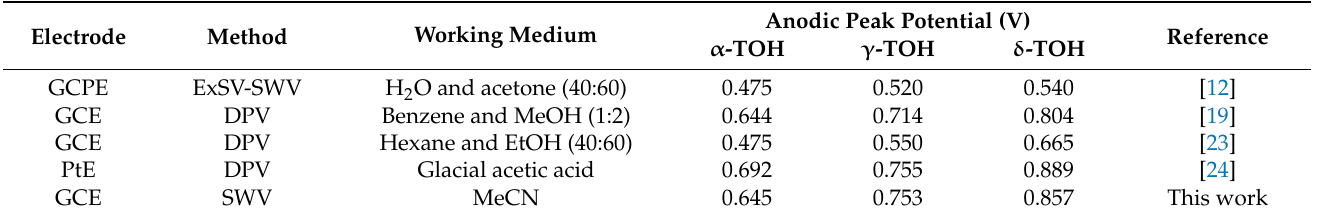
Table 1. Comparison of electrode material and working medium on anodic potential